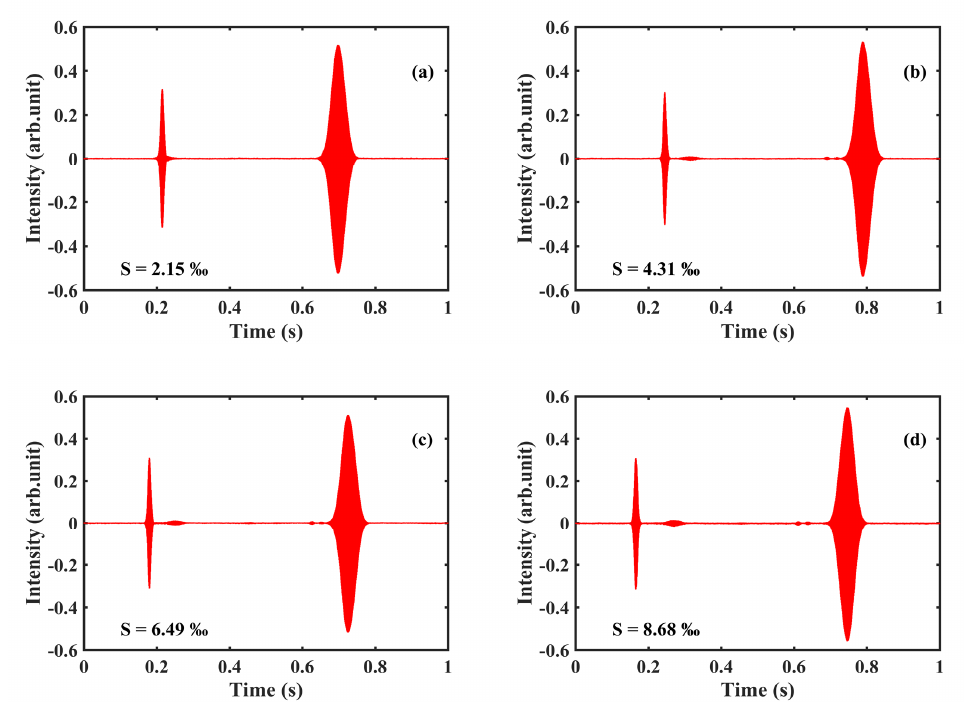
Appl. Sci. 2019 , 9 , x FOR PEER REVIEW Figure 9. ( a ) Cross-correlation patterns in 2.15‰; ( b ) cross-correlation patterns in 4.31‰; ( c ) Figure 9. ( a ) Cross-correlation patterns in 2.15% (cid:24) ; ( b ) cross-correlation patterns in 4.31% (cid:24) ; ( c ) Cross-correlation patterns in 6.49‰; ( d ) cross-correlation patterns in 8.68‰. Cross-correlation patterns in 6.49% (cid:24) ; ( d ) cross-correlation patterns in 8.68% (cid:24) .